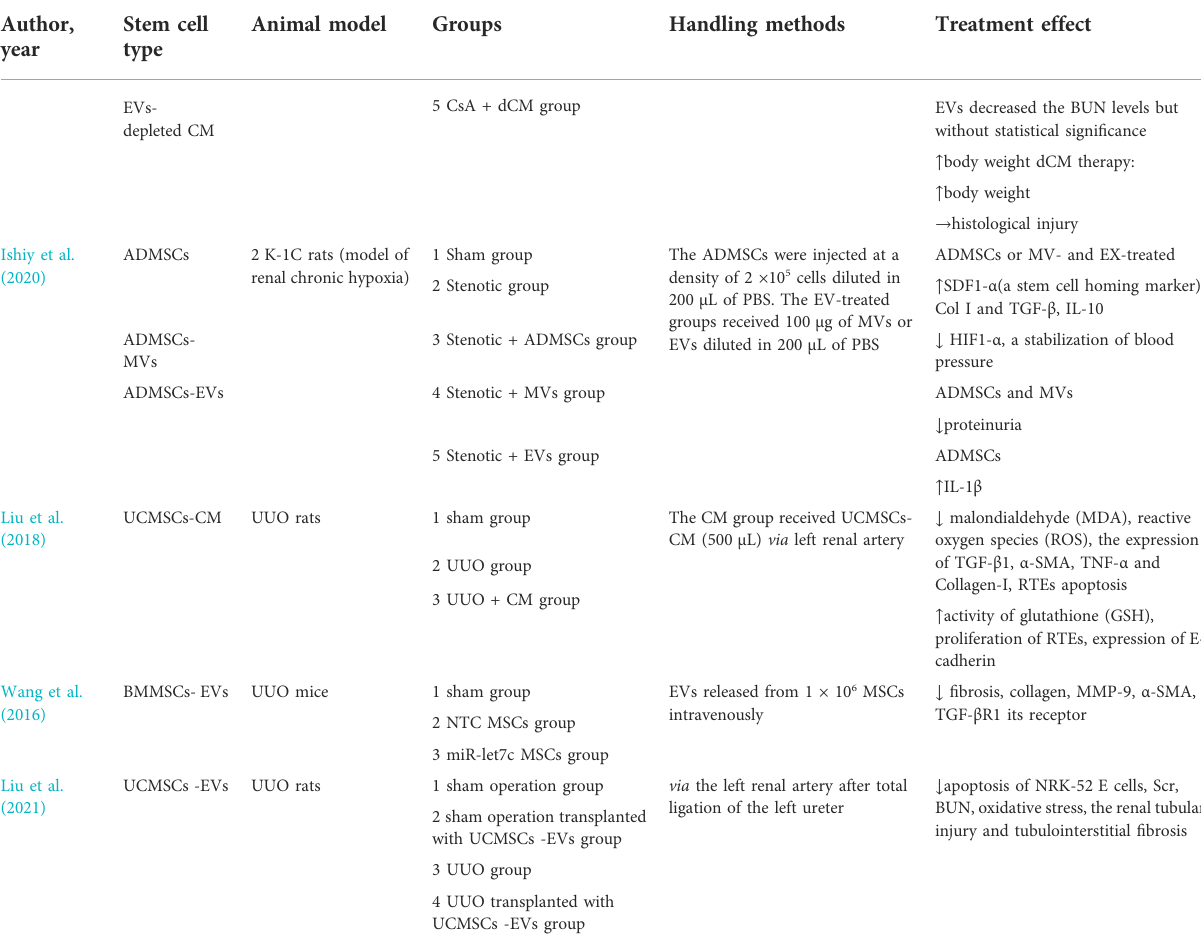
TABLE 1 ( Continued ) Summary of preclinical data of MSCs in